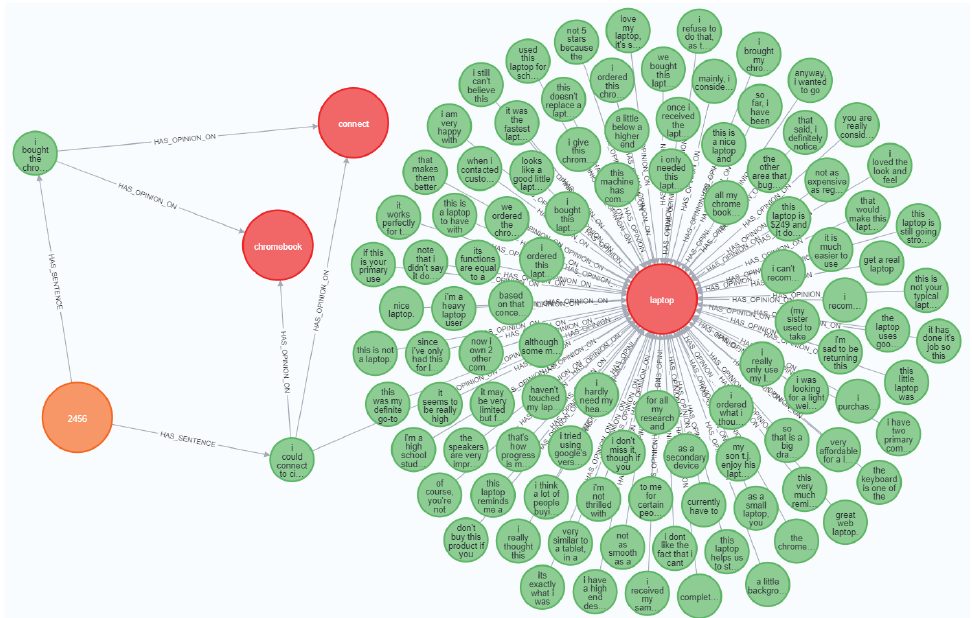
Figure 5. Sub-graph of review 2456 with two sentences, which opinions on three aspect keywords where keyword connect is mentioned in 103 other